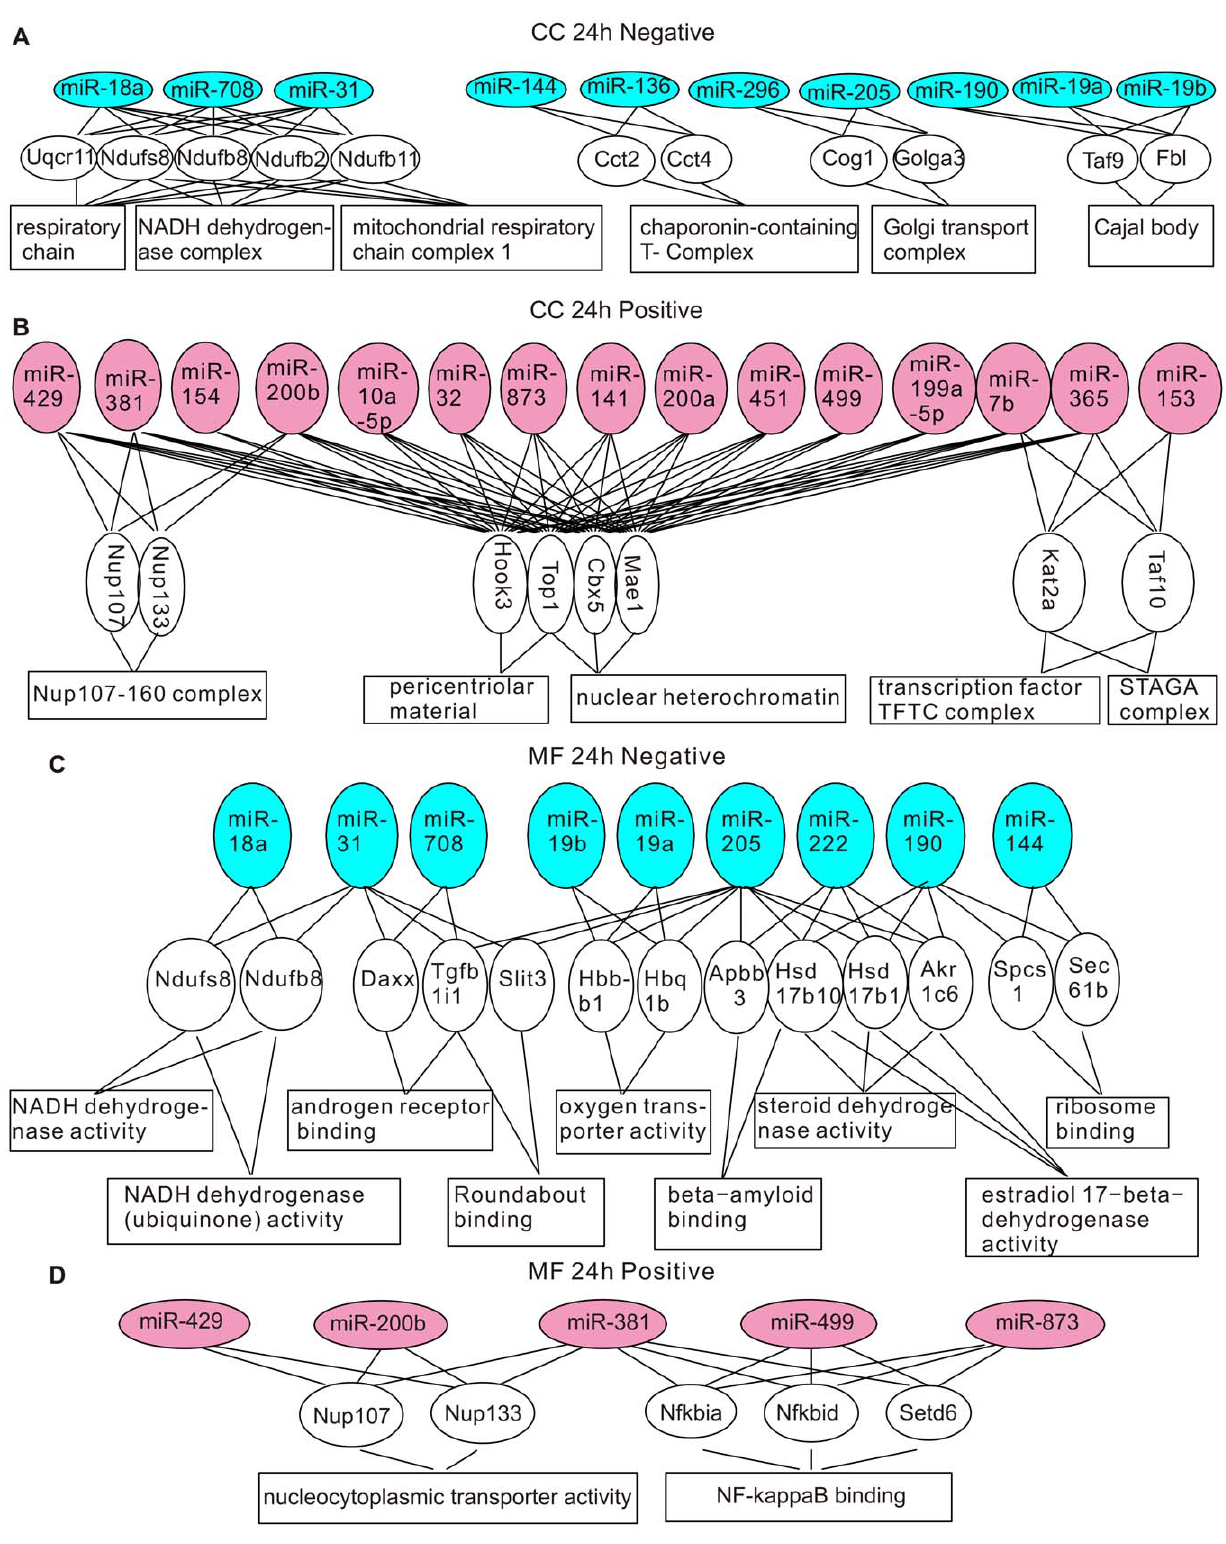
Figure 4. Genes and GO terms in the cellular component and the molecular function ontology that are over-represented by differentially expressed miRNAs at 24 hours post-CCI. (A) Genes and GO terms in the cellular component ontology enriched by down- regulated miRNAs. (B) Genes and GO terms in the cellular component ontology enriched by up-regulated miRNAs. (C) Genes and GO terms in the molecular function ontology enriched by down-regulated miRNAs. (D) Genes and GO terms in the molecular function ontology enriched by up- regulated miRNAs.